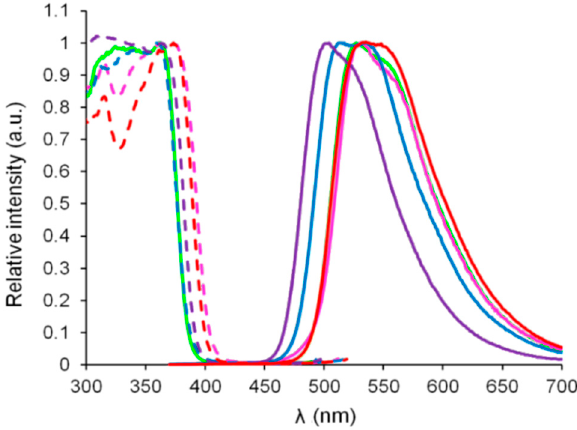
Figure 4. Photographs of HBO 1 – 5 (from left to right) as powders under daylight ( top ) and under irradiation at λ exc = 365 nm ( bottom ).